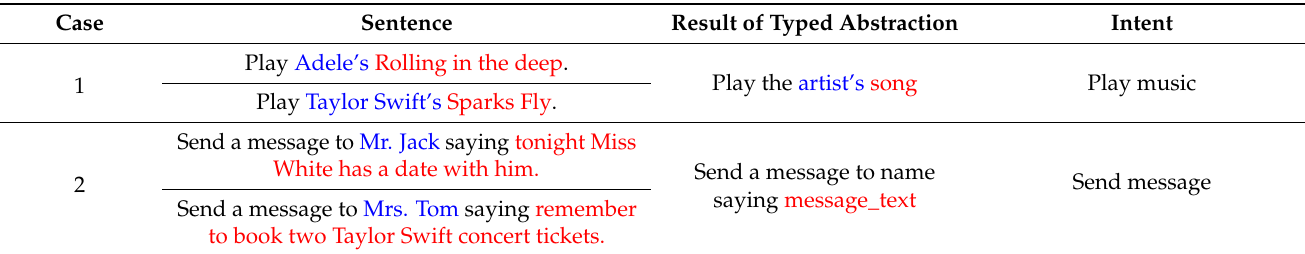
Table 2. Two examples of misleading information; different colors correspond to different slots. It is still easy to identify the intent only by the Result of Typed Abstraction section, containing only slot categories and not specific slot